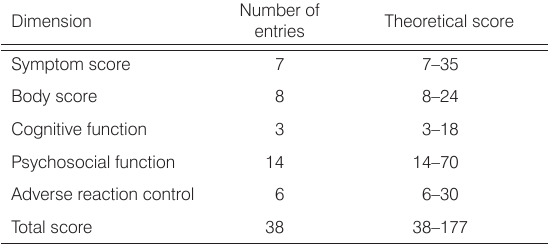
Table 1. CROQ quality-of-life scoring